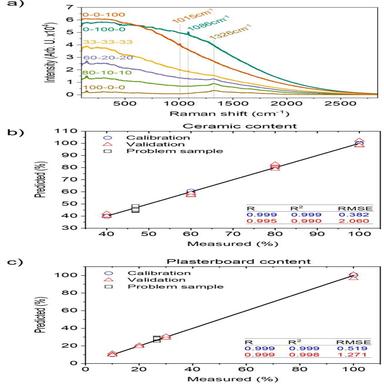
Raman spectra of experimental mixtures for the model building (a). PLS predicted vs. measured wt% of brick (b) and plasterboard (c) including the calibration, validation and problem values used for the model building and application. R, R square and RMSE values are shown in each graph, matching the colors for the calibration (blue), validation (red) and problem sample (black) data.